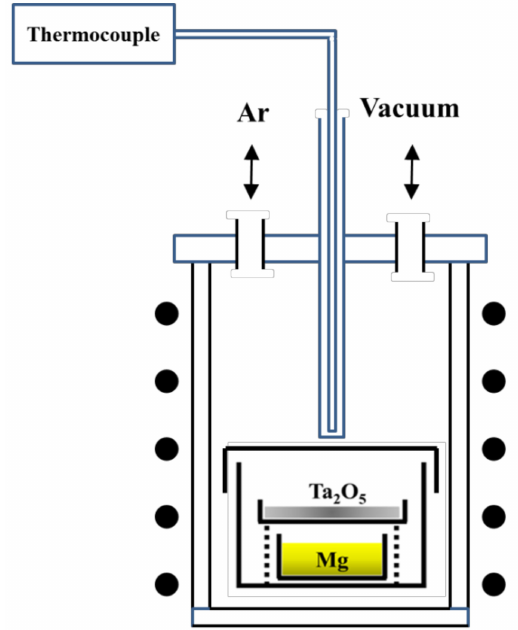
Figure 1. Schematic structure of the reactor for Mg reduction of Ta 2 O 5